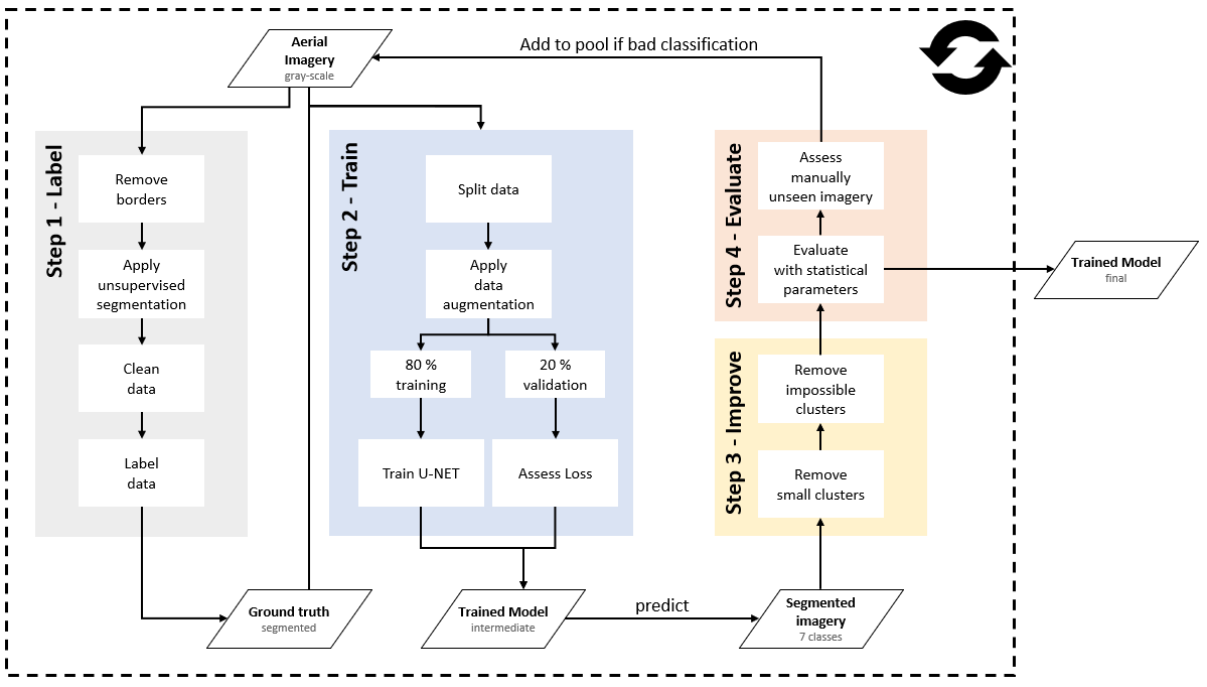
Figure 2. Flow chart of the processing chain from aerial imagery to trained model. All steps inside the dashed rectangle are applied in an iterative process.